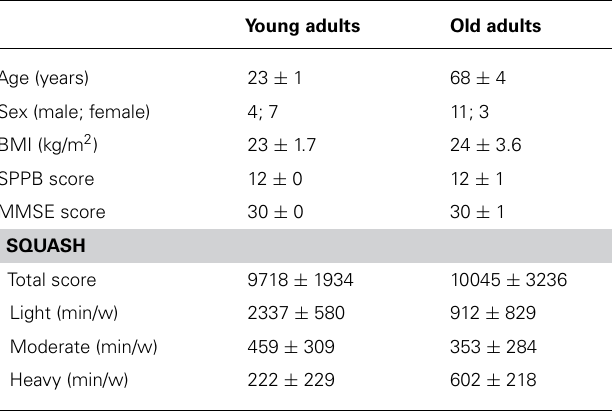
Table 1 | Subject